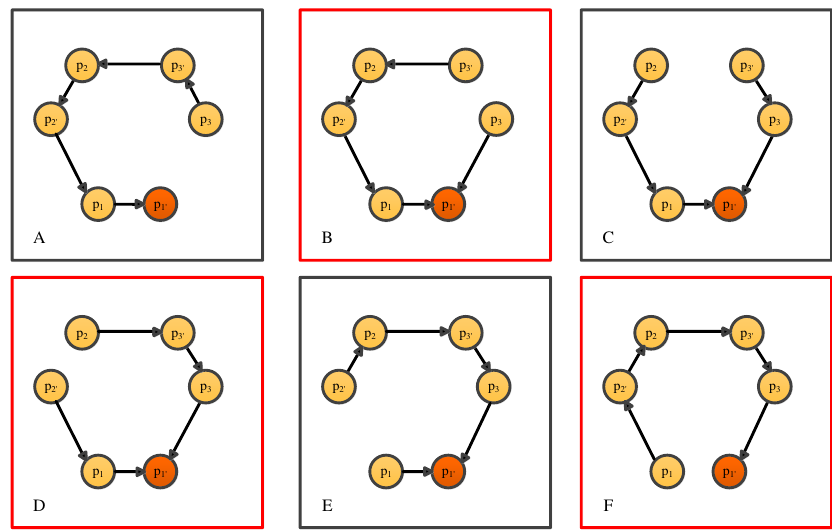
Figure 3. Six different phase-locking